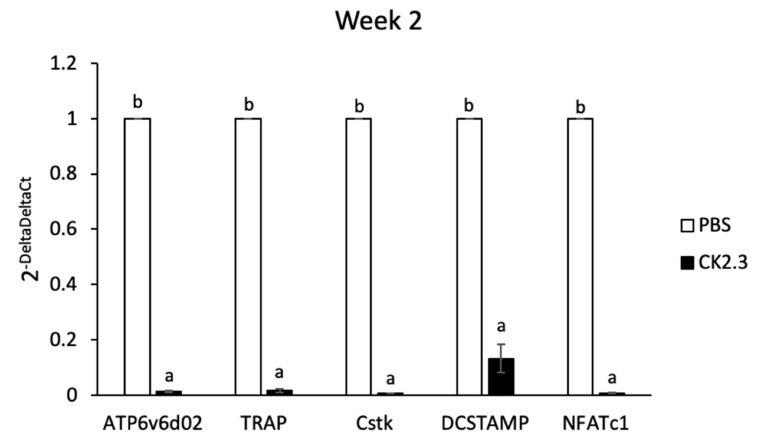
Figure 9. Analysis of osteoclast markers in primary preosteoclasts isolated from the spleens of 6-month-old retired breeder mice by RT-PCR. Primary preosteoclasts were di ff erentiated to osteoclasts with RANKL for 7 days. Osteoclast markers were downregulated at Week 2 after the first injection of CK2.3. a: denotes significant di ff erence from PBS, and b: denotes significant di ff erence from CK2.3. 3.7. CK2.3 Uptake into the Femurs of 6-Month-Old Retired Breeder Mice Was Detected at Week 2